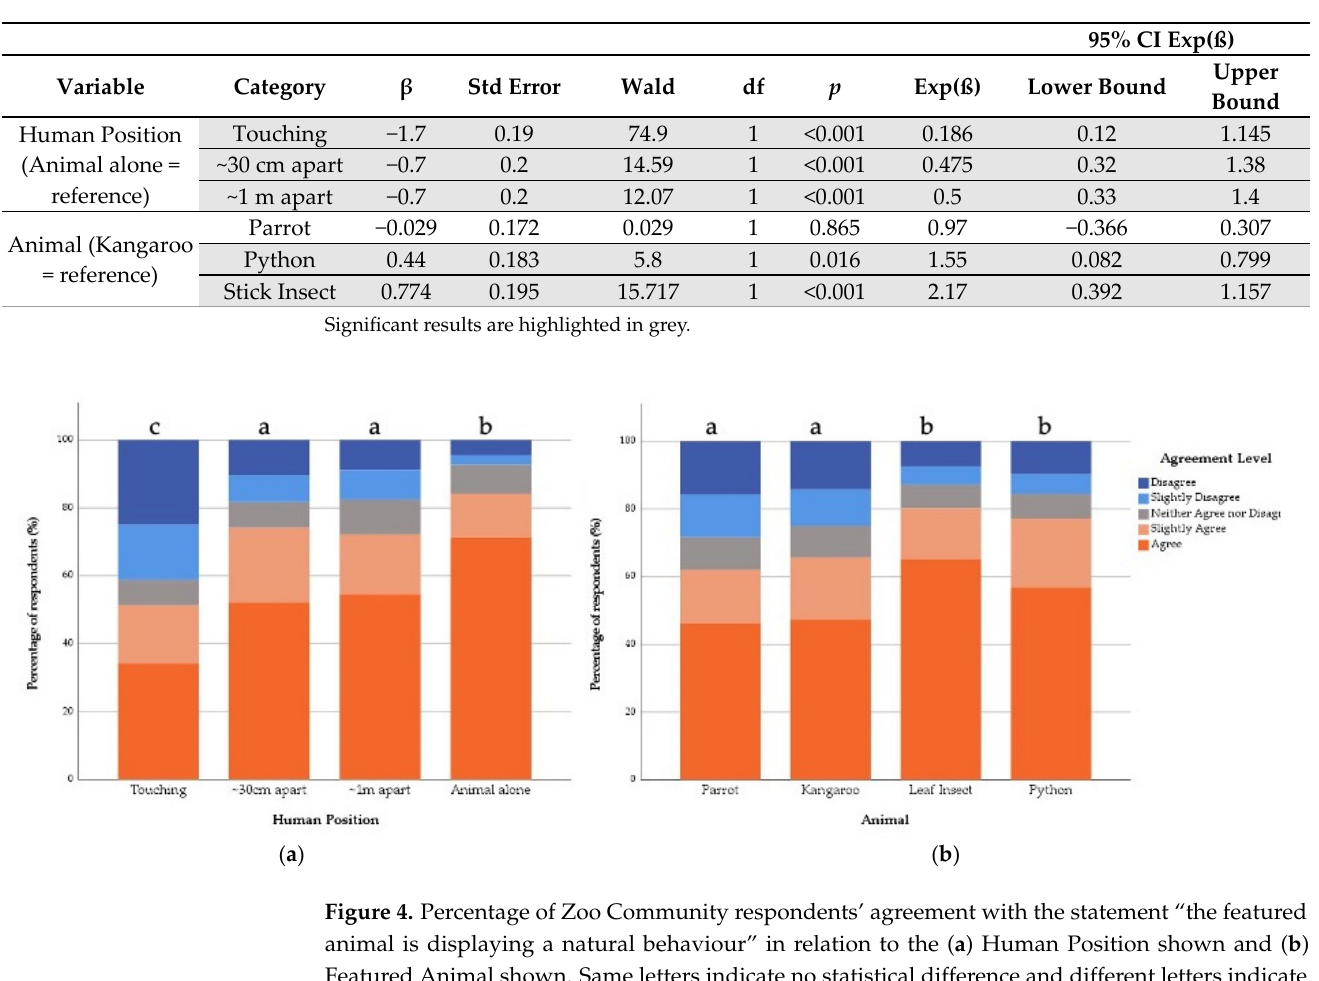
Figure 3. Percentage of General Public respondents’ agreement to the statement “the featured ani- mal is cared for by the zoo” in relation to the allocated images (Featured Animal by Human Posi- tion).